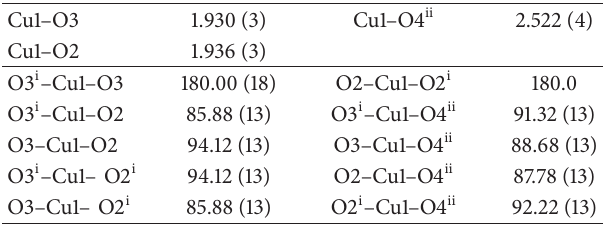
Figure 3: Experimental (black line) and theoretical (red line) Q- band EPR spectra from a frozen chloroform solution of Cu(II) complex. The inset focuses on the 𝑔 || part of the spectrum. EPR conditions: temperature, 100K; modulation amplitude, 5 Gpp; microwave power, 1.3 mW; microwave frequency, 34.4 GHz. Table 2: Selected bond lengths (˚A) and angles ( ∘